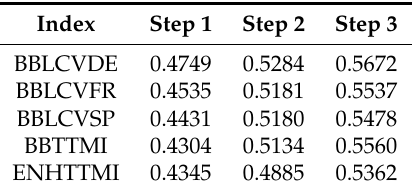
Table 7. Comparison of the ratios of mean absolute error for models for intermediate goods with an expanding window from 2008:01 to 2018:12.